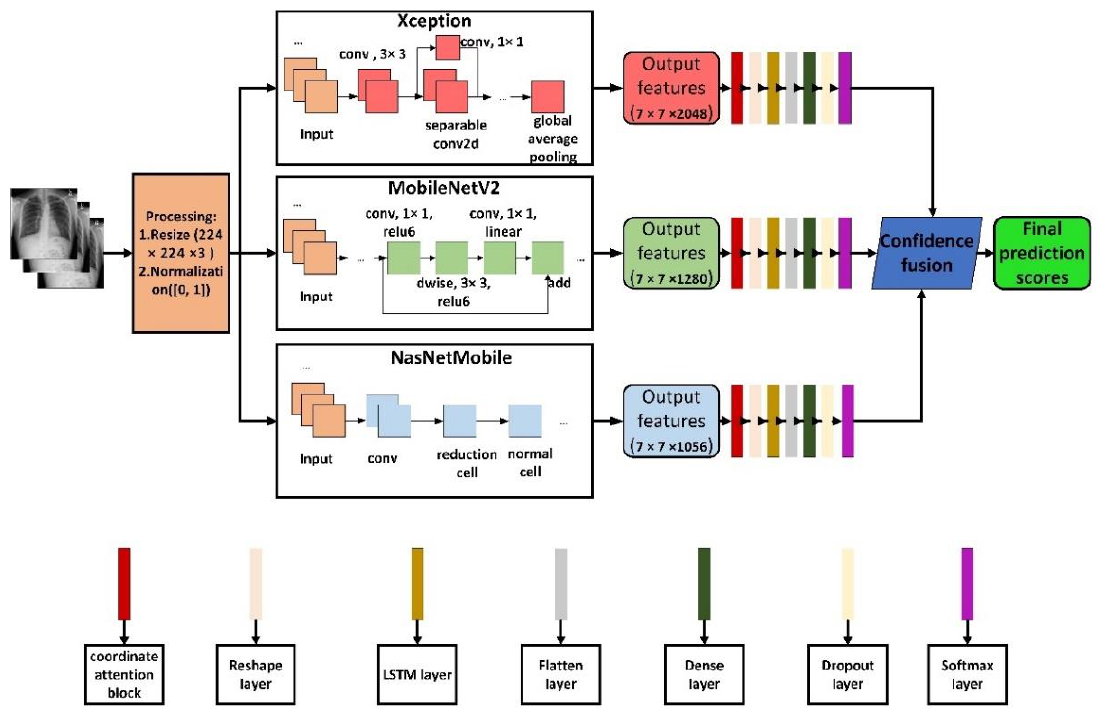
Figure 1. Specific details of the proposed